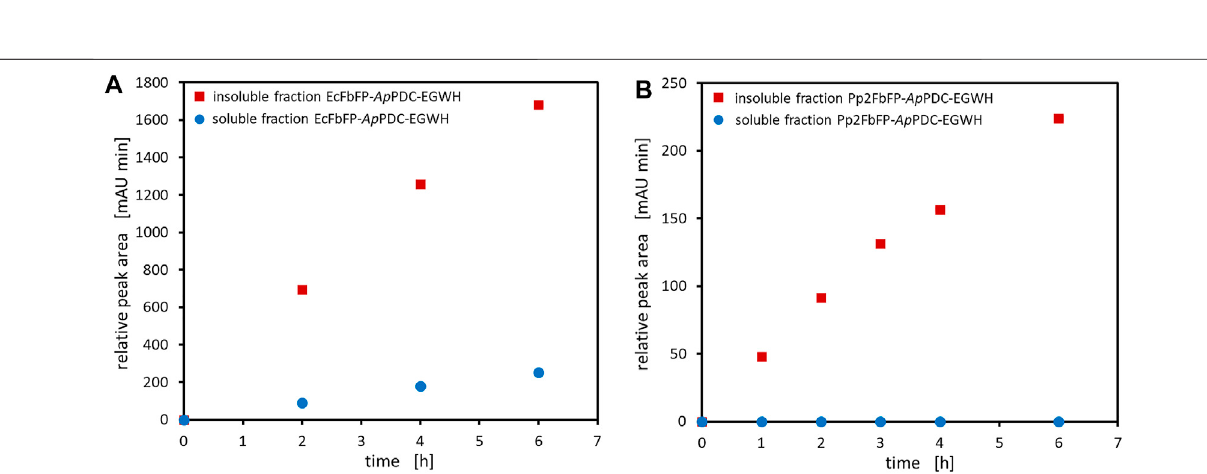
FIGURE 4 | Schematic representation of the formation of insoluble three-dimensional protein aggregates by the combination of a dimeric photosensitizer with a tetrameric enzyme. Green: dimeric photosensitizers (EcFbFP or Pp2FbFP); blue: tetrameric Ap PDC-EGWH.